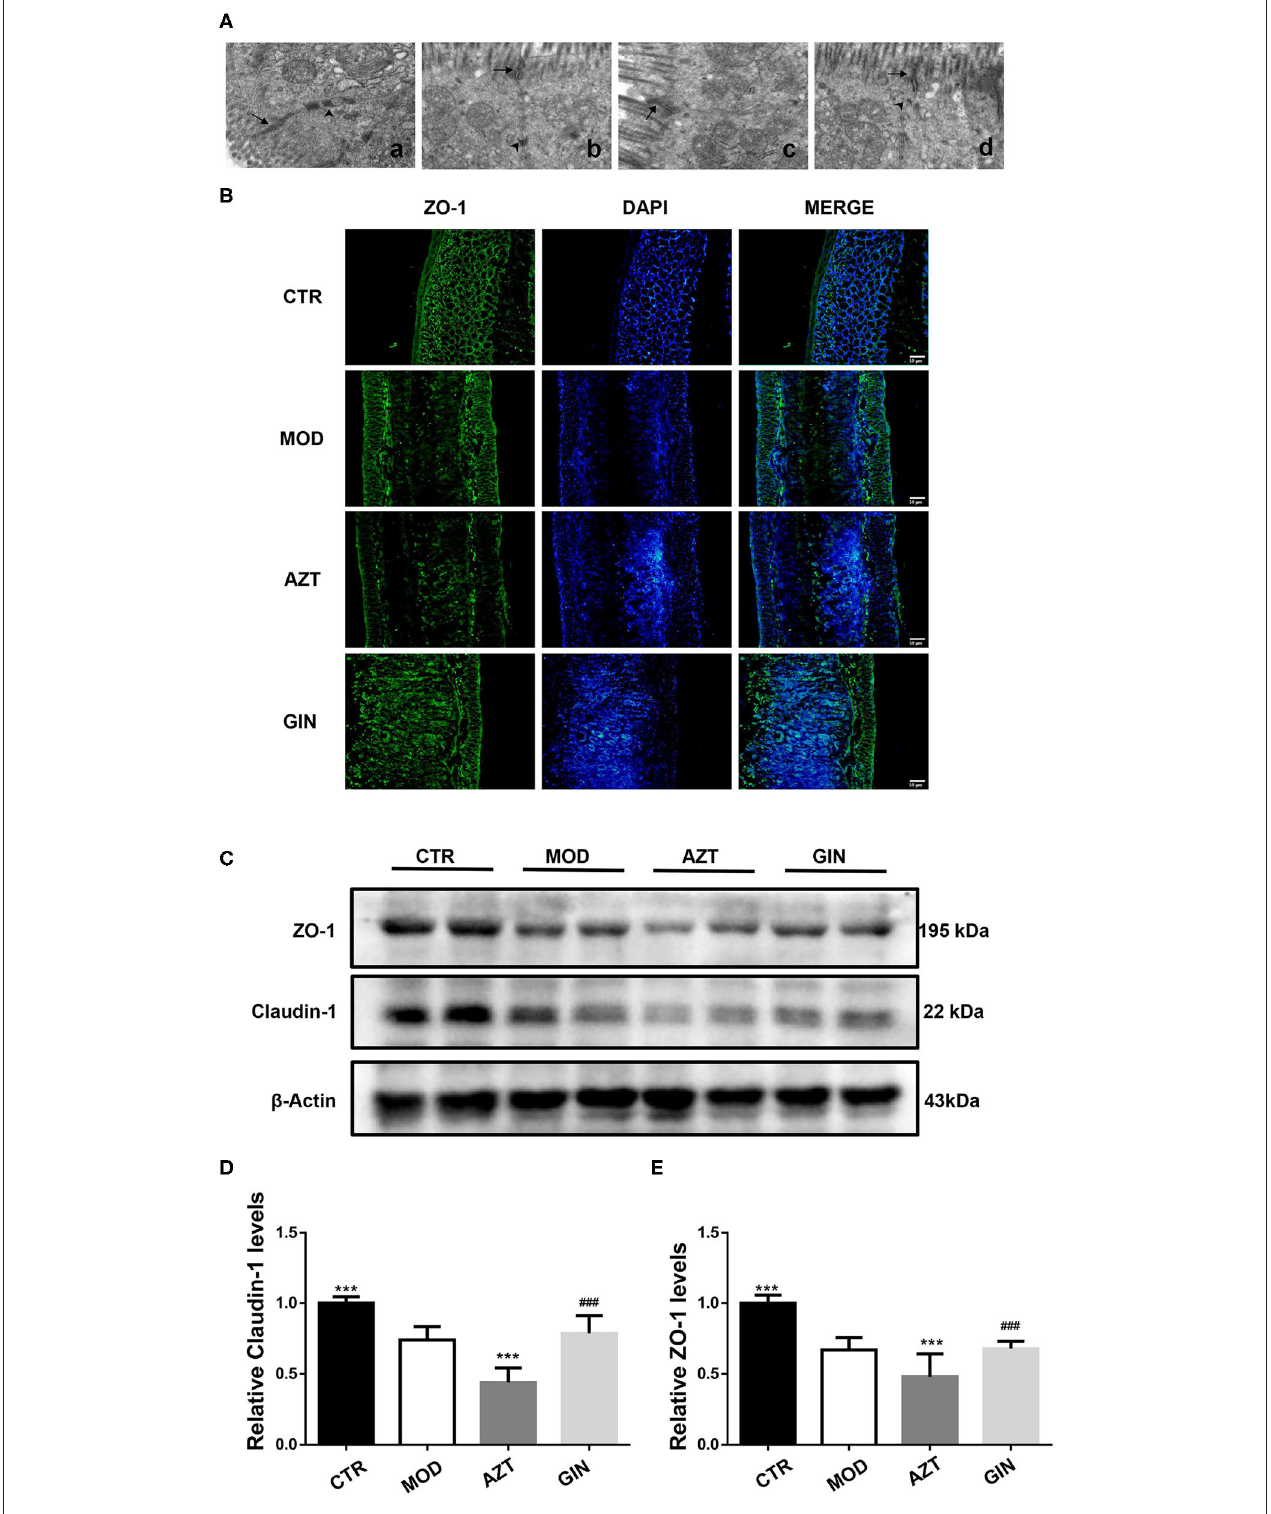
FIGURE 3 | Ginger improves the intestinal barrier function of mice with DSS-induced colitis exposed to AZT in early life. (A) TJ morphology (magnification, × 8000): (a) CTR group; (b) MOD group; (c) AZT group; and (d) GIN group. Arrows, TJ; arrow heads, desmosome. (B) Representative images of immunofluorescence of ZO-1 in colon sections. (C) Western blot analysis of claudin-1 and ZO-1 expression in colon tissue. (D) and (E) Relative levels of claudin-1 and ZO-1 ( n = 4). *** p < 0.01 vs. MOD group; ### p < 0.01 vs. AZT group.